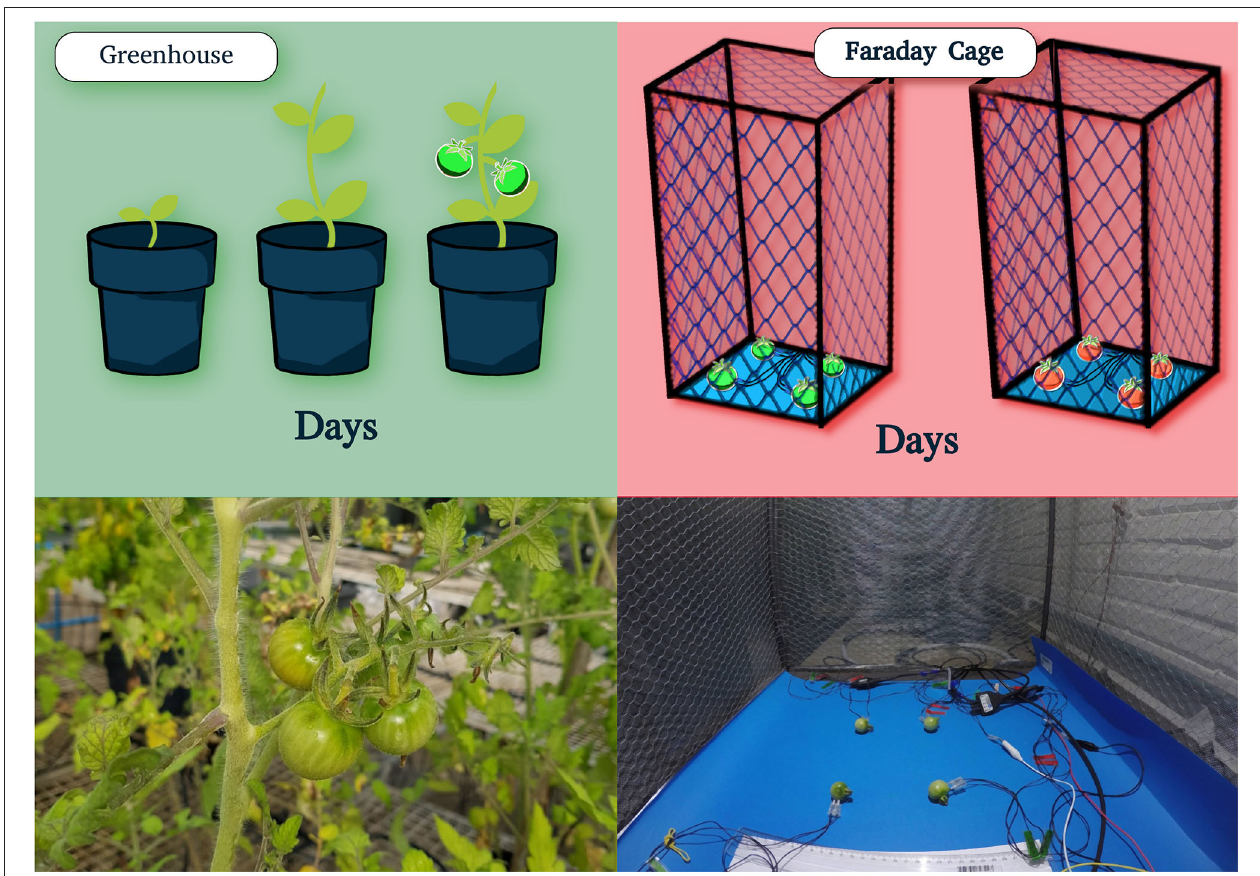
FIGURE 1 | Experimental scheme of plant growth and experimental setup. Tomato plants were grown in greenhouse until fruit reach mature green (MG) ripening stage (upper left quadrant). Illustration of cherry tomato fruit vine (lower left quadrant). MG fruit was harvested and transported to the electrophysiology room, where it was placed in a Faraday’s cage and a pair of electrode was inserted in each fruit, totaling four per replicate. The recording of electrical signals through ripening stages were conducted in the same fruit placed initially (upper right quadrant). Illustration of fruit’s electrophysiological measures in a Faraday’s cage (lower right